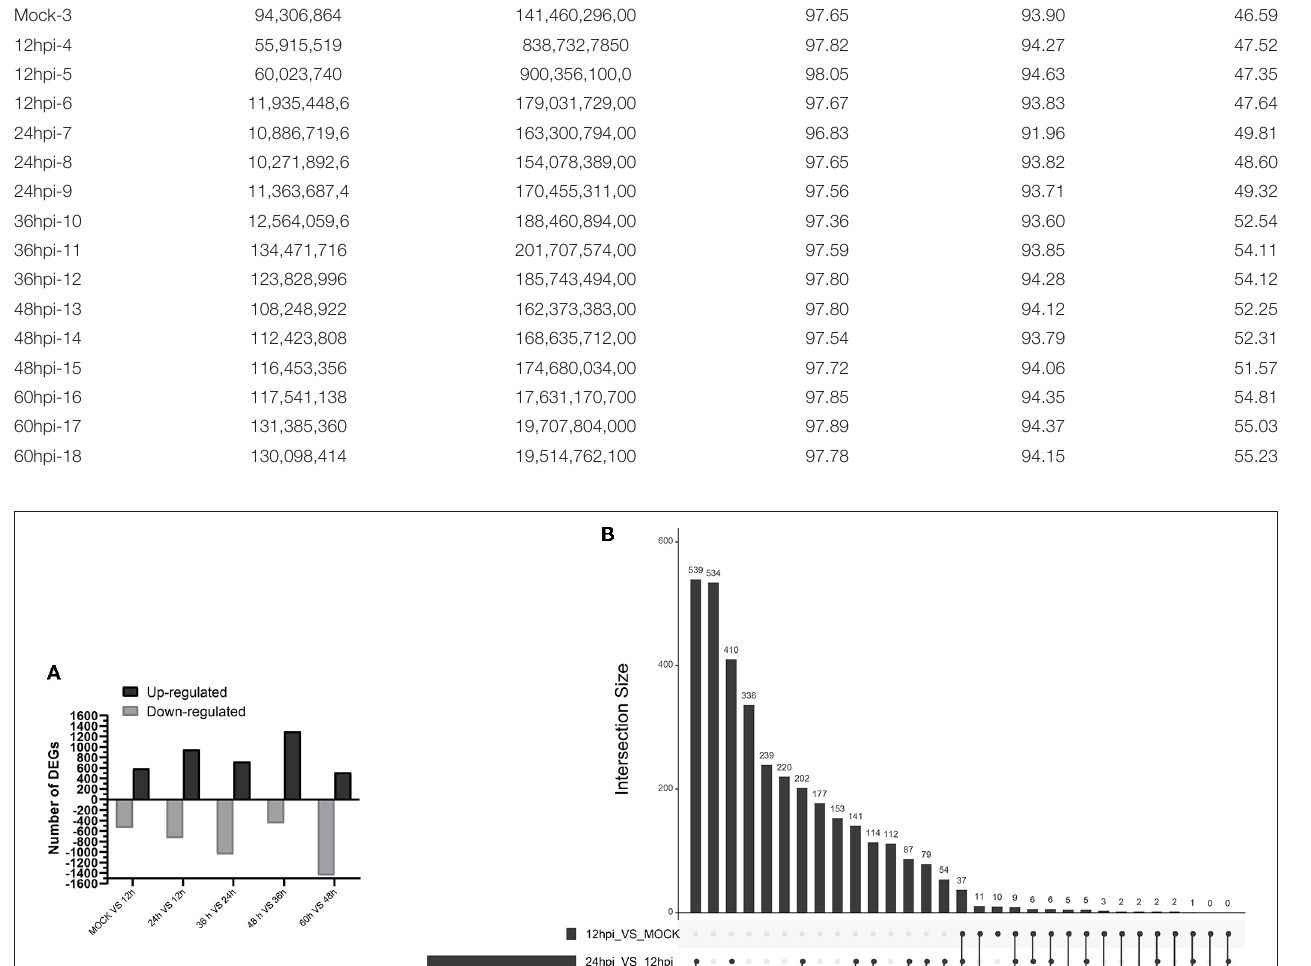
TABLE 1 | Statistics of the RNA-seq dataset. Sample